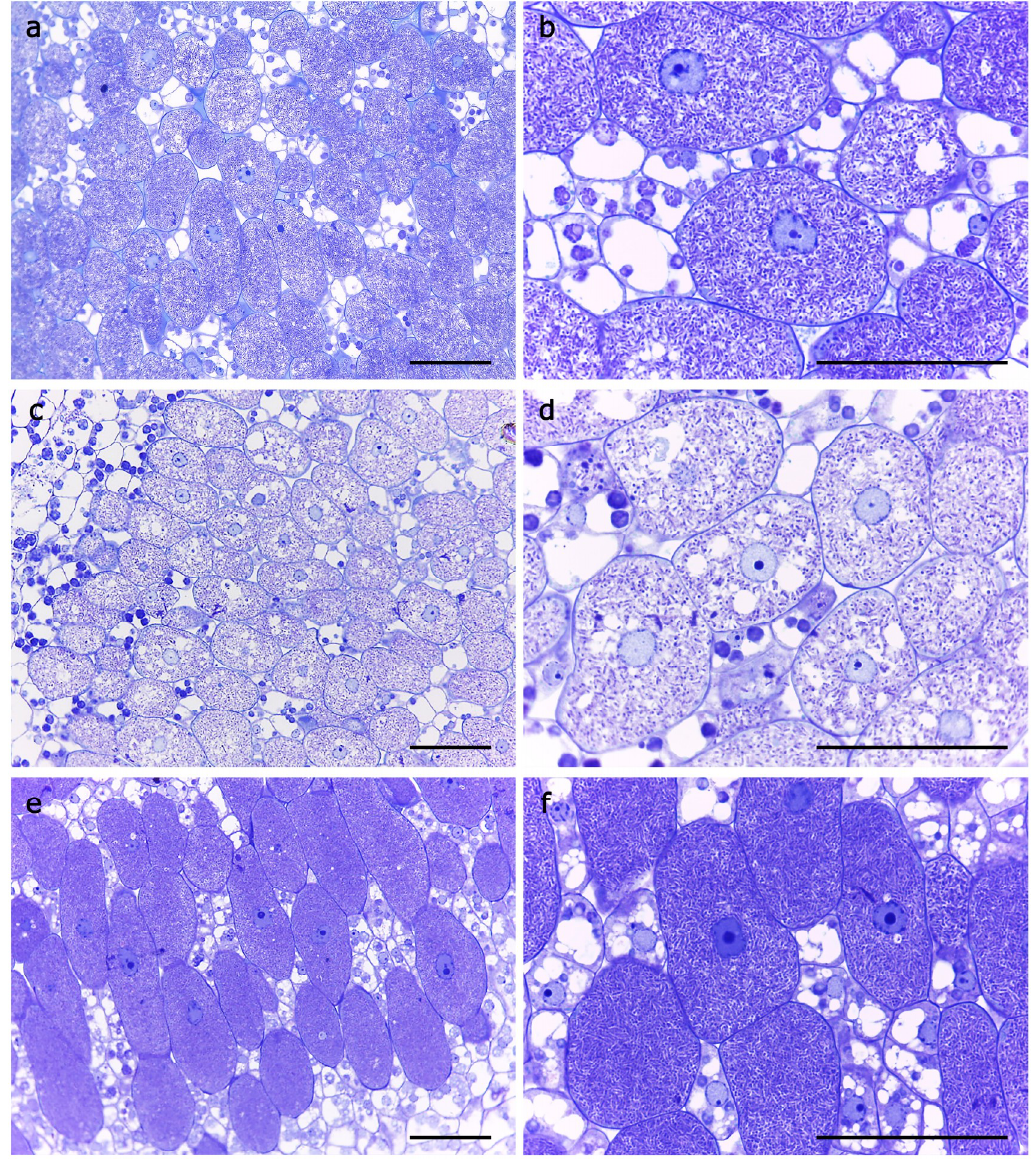
Figure 5. Optical microscopy of nodules induced in G. max cv. Williams by S. fredii wild-type strain SVQ269 ( a – b ); rirA mutant SVQ780 ( c – d ); and complemented strain SVQ780C ( e – f ). Bars correspond to 50 µm.